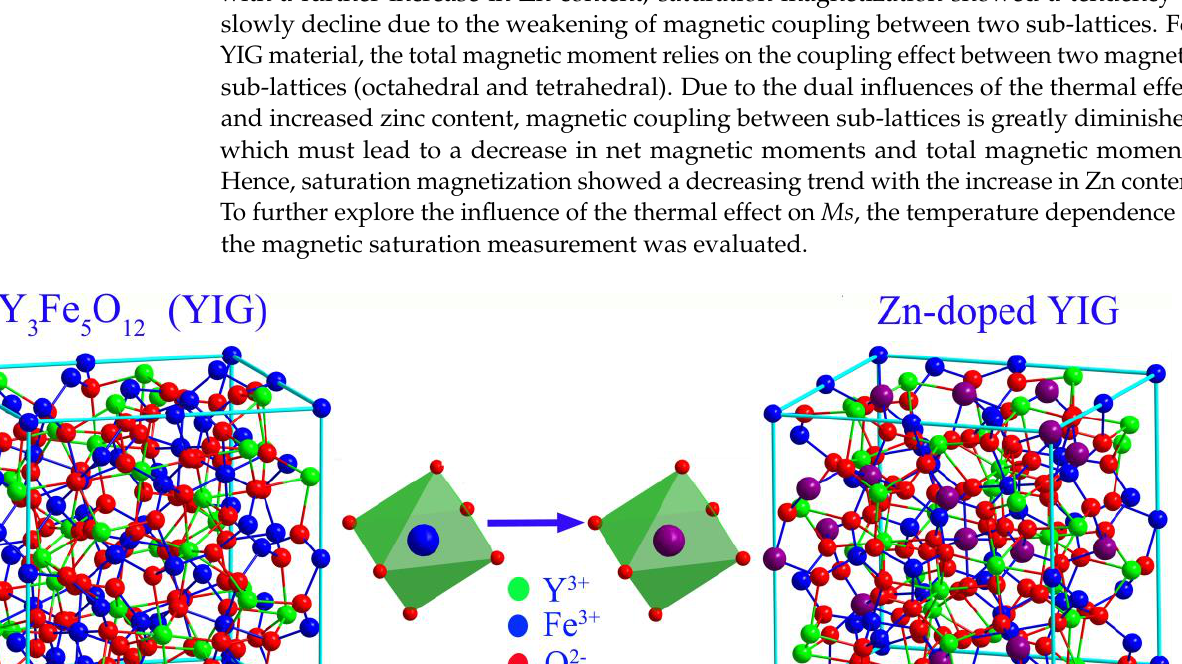
Figure 5. Crystal structure evolution model .